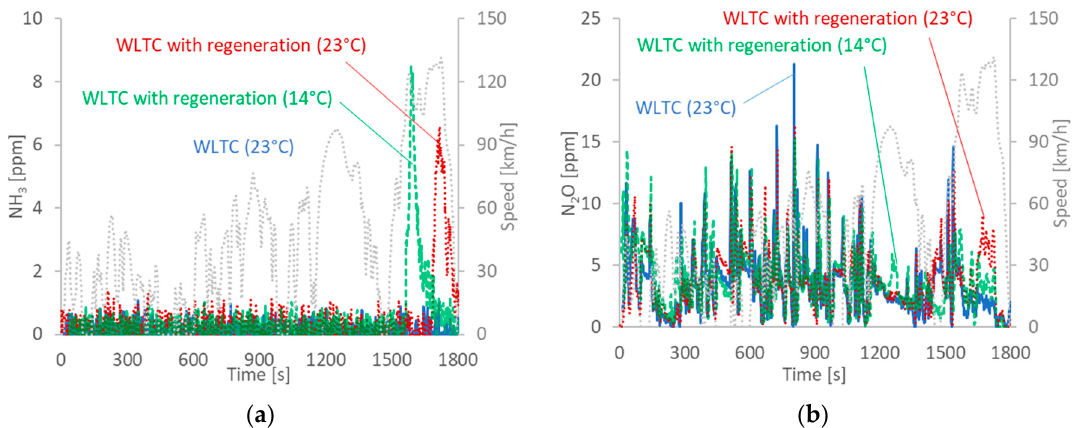
Figure 4. Real time concentrations over the Worldwide Light-duty Test Cycle (WLTC) at 23 ◦ C and 14 ◦ C with and without regeneration: ( a ) NH 3 ; ( b ) N 2 O. Measurements from the tailpipe with FTIR (Fourier Transform Infrared Spectrometer).